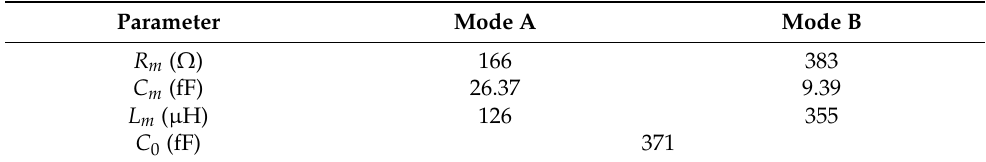
Figure 2. Modified Butterworth-Van Dyke (MBVD) model for the array at 25 °C, after the 500 °C burn-in. Table 1. Extracted values for the MDVD model shown in Figure 2.